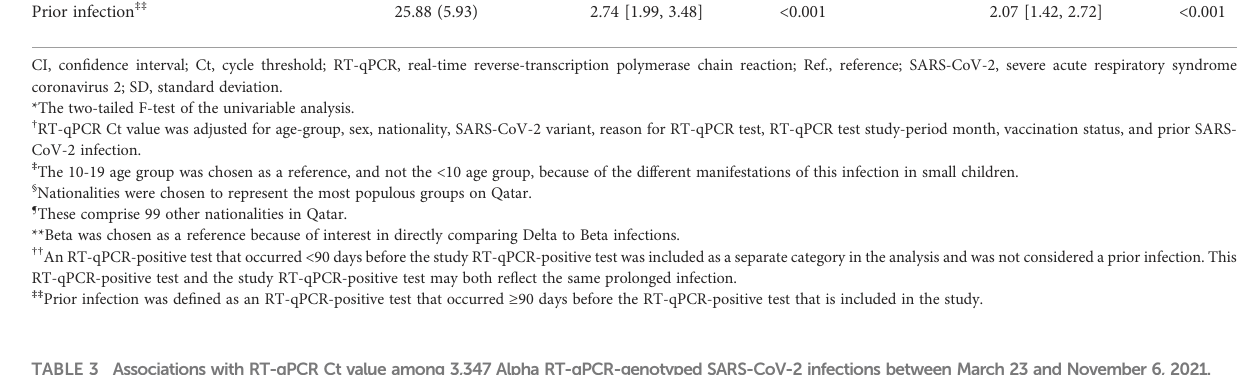
TABLE 3 Associations with RT-qPCR Ct value among 3,347 Alpha RT-qPCR-genotyped SARS-CoV-2 infections between March 23 and November 6, 2021.